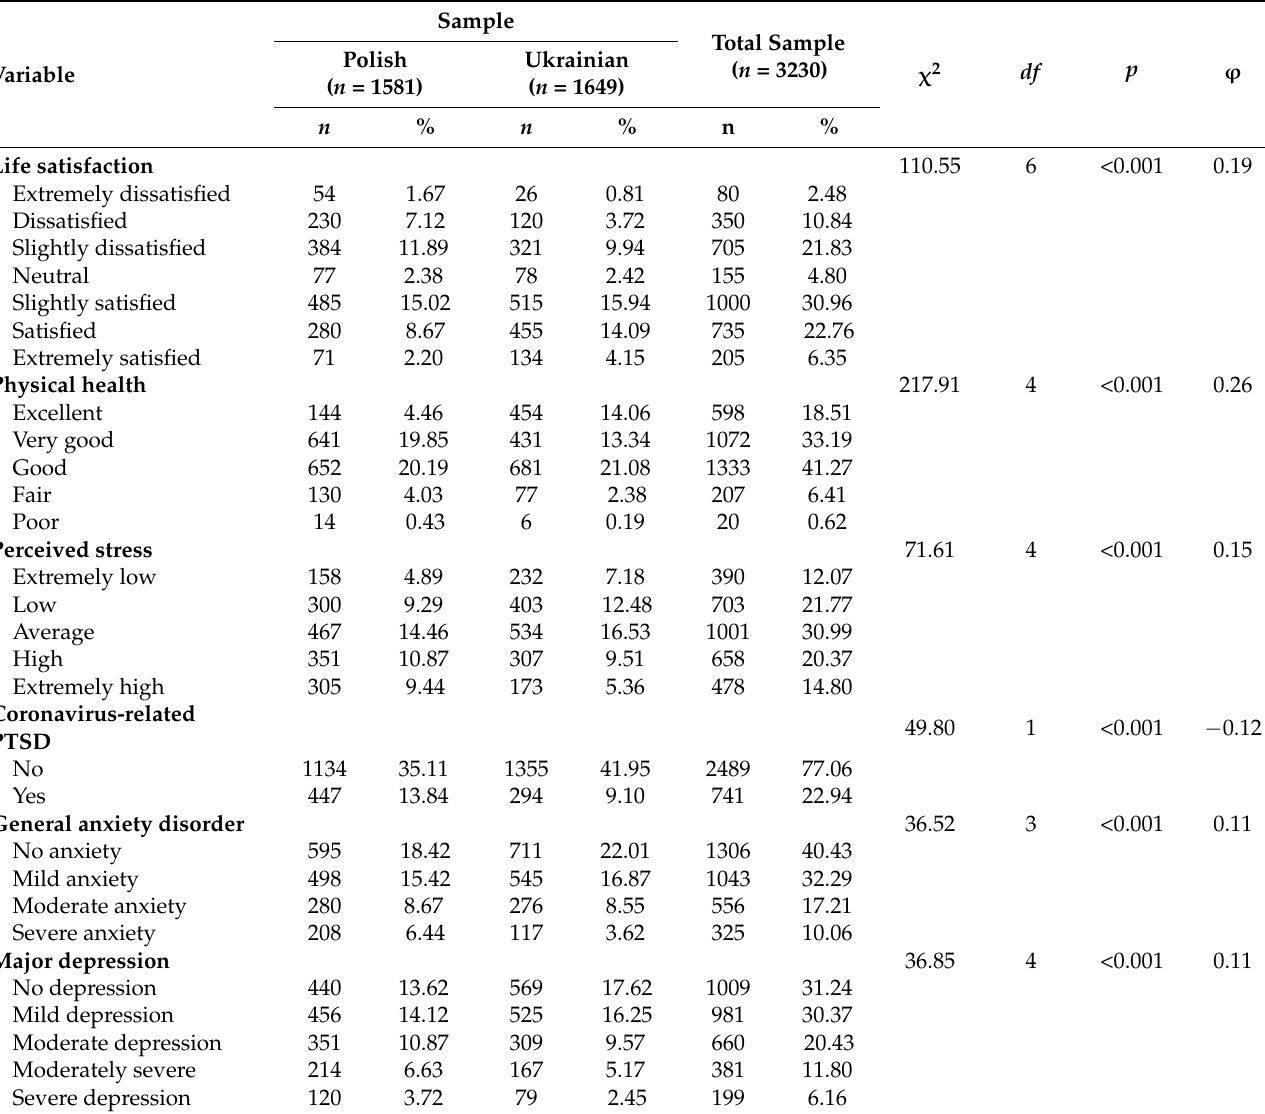
Table 2. Frequencies of particular categories of life satisfaction, physical health, perceived stress, coronavirus-related PTSD, anxiety, and depression ( N =